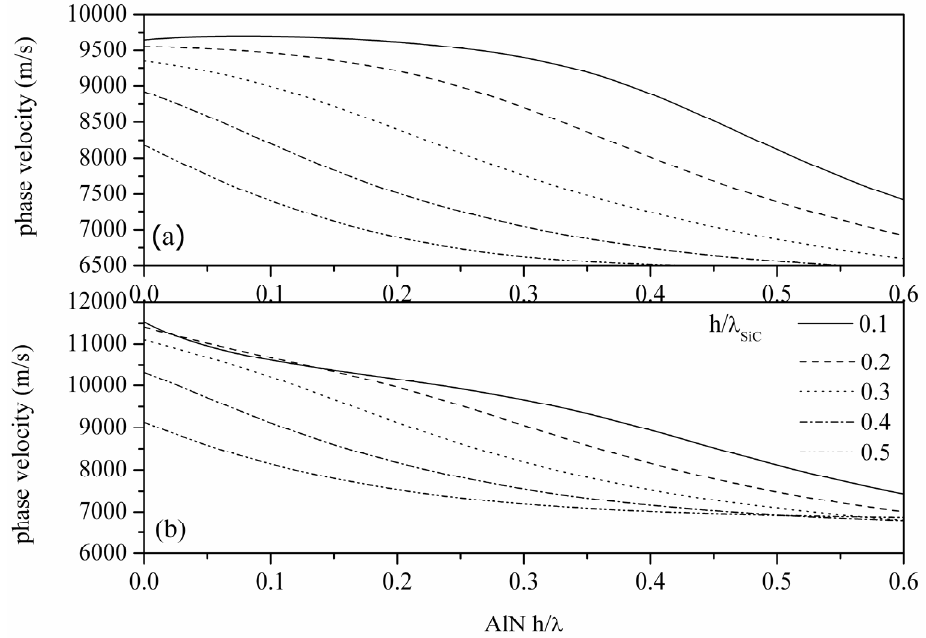
Figure 2. The dispersion curves for the S c-AlN/SiC(001)<100> and ( b ) along